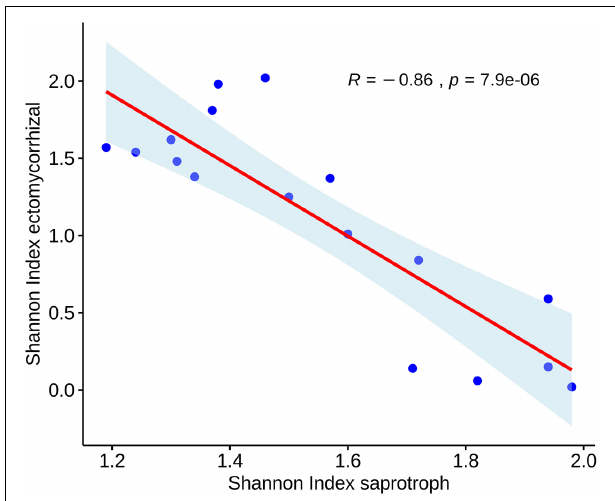
FIGURE 7 | Scatterplot showing the Pearson’s correlation between biodiversity values (Shannon index) measured for ectomycorrhizal and saprotrophic